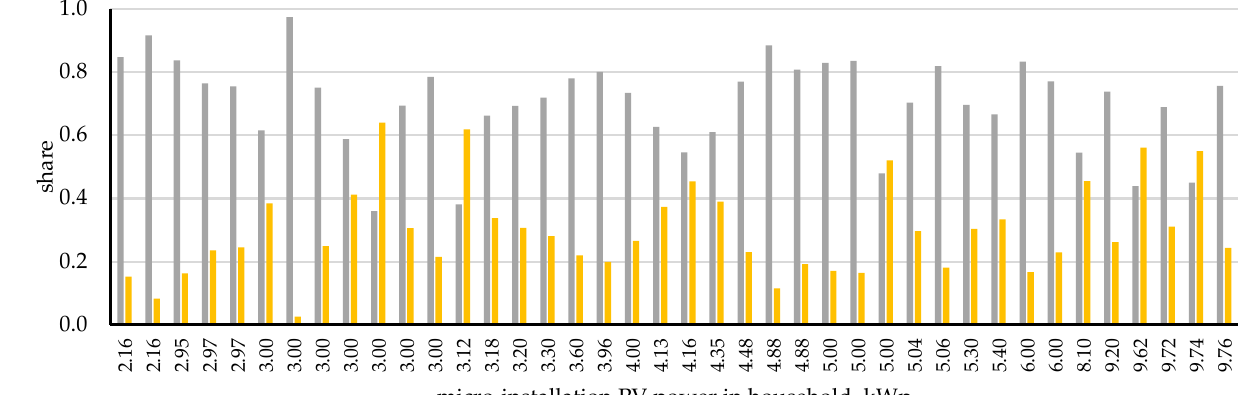
micro-installation PV power in household, kWp energy sent to the grid/insolation max. self-consumed/insolation Figure 5. Annual values of energy sent to the grid in relation to insolation and the maximum annual self-consumed (max. self-consumed/insolation) share in the Kuyavian-Pomeranian province, 2019. Source own study based on [32].